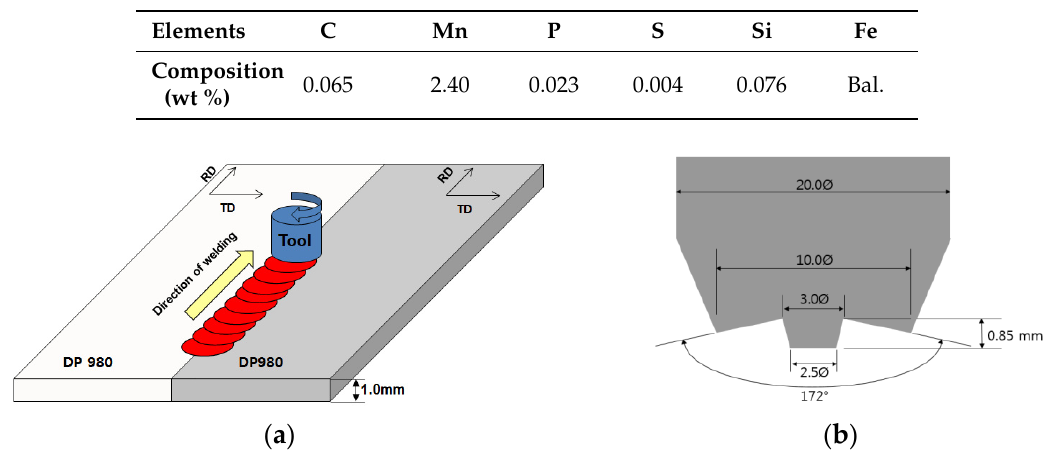
Table 1. Chemical composition of the DP980 steel used in the present study (wt %).